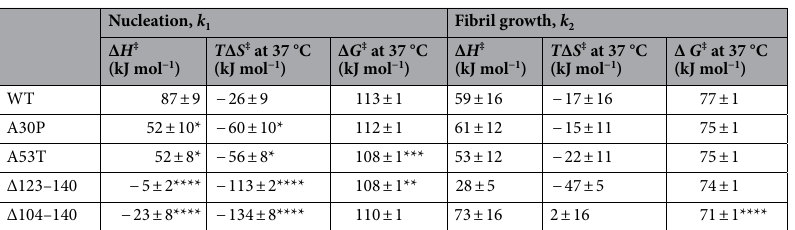
Table 1. Thermodynamic parameters for nucleation and fibril growth of fibril formation of α-syn variants. The values of Δ H ‡ and Δ S ‡ were determined from the slope and y-intercept of Eyring plots shown in Fig. 7C. The values of Δ G ‡ were calculated from k 1 and k 2 values at 37 °C according to Eq. (6). * p < 0.05; ** p < 0.01; *** p < 0.0005; **** p < 0.0001 versus each parameter of WT.